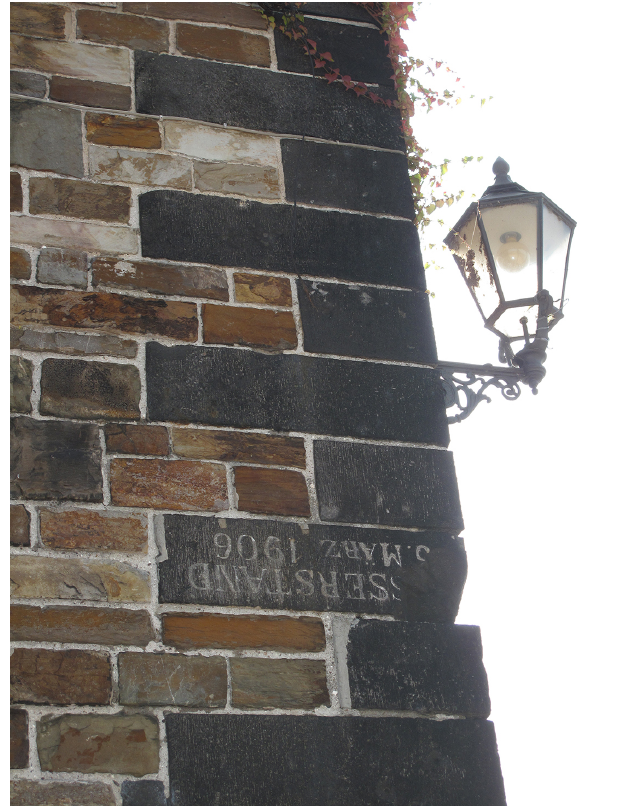
Figure 6. Stone brick with an inscription of the 1906 flood mark of the River Rhine in Koblenz. The block was originally placed on a railway bridge destroyed during World War II and later used for reconstruction of this building (Herget, 2012). This confirms the necessity to work only with the original position of flood marks and to use multiple documentary evidence to reconstruct flood